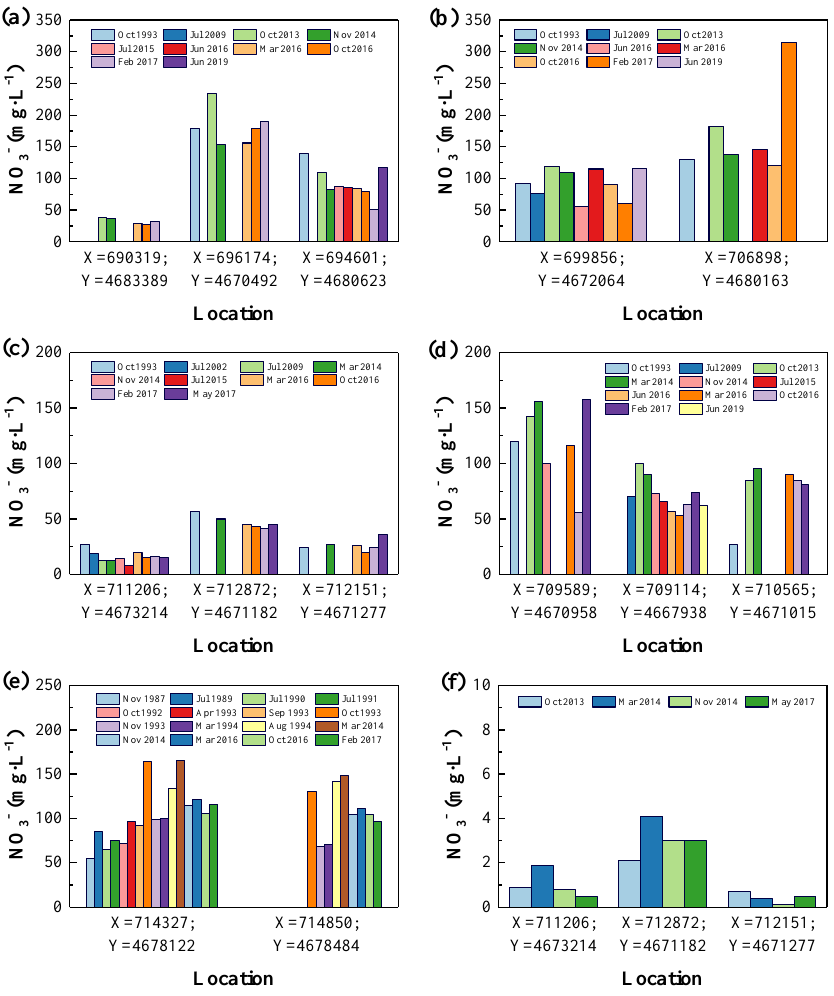
Figure 7. Historical evolution of nitrate concentration in the western side of Hoya de Huesca County, from reports by several authors [25 – 29,32,33], academic works, and unpublished official health reports. ( a , b ) Saso Bolea Ayerbe aquifer; ( c , d ) Hoya Huesca aquifer; ( e ) Apiés aquifer; ( f ) Pre-Pyrenees aquifer. Note: y-axis scales are different for each aquifer. All coordinates in the x-axes labels refer to UTM zone 30N.